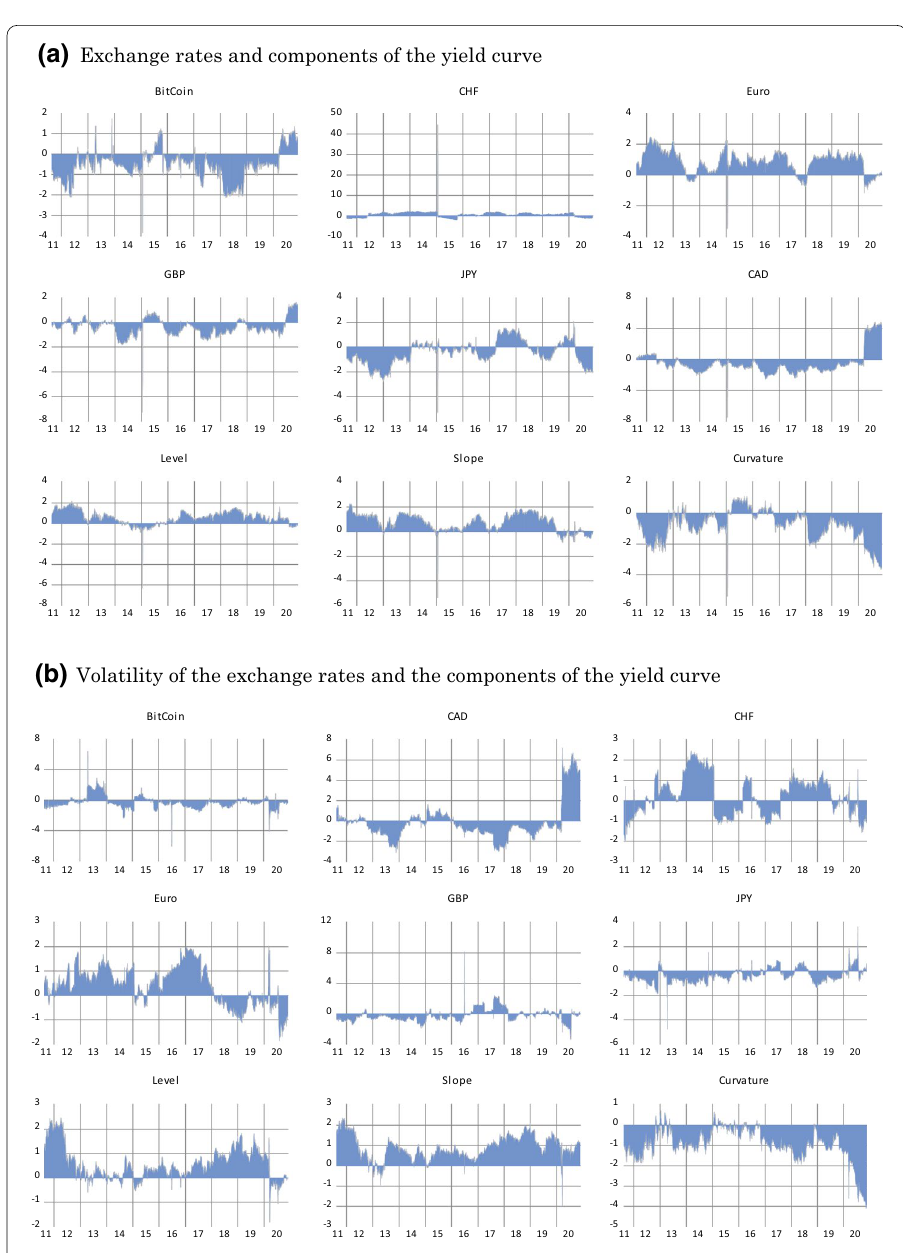
Fig. 3 Net Dynamic Connectedness Measure of the System. a Exchange rates and components of the yield curve. b Volatility of the exchange rates and the components of the yield curve. Notes : The figures describe the dynamic net spillover between each variable and the whole system. Positive values indicate a variable X as a net transmitter, while negative values indicate a variable as a net receiver in the system. The top figure represents the spillover of the system of the yield curve components and the exchange rate of Bitcoin and the safe haven currencies. The bottom figure shows the spillover of the yield curve components and the volatility of Bitcoin and the safe haven currencies. The rest of notations as in Fig.